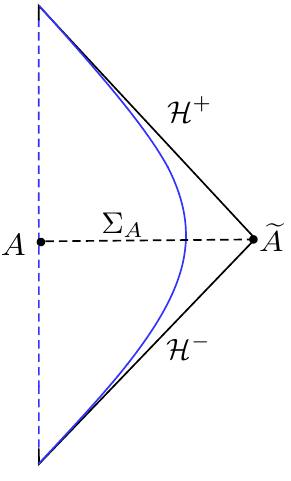
( A ) at r B (dashed blue line) is D ! 1 1 (solid blue line). !